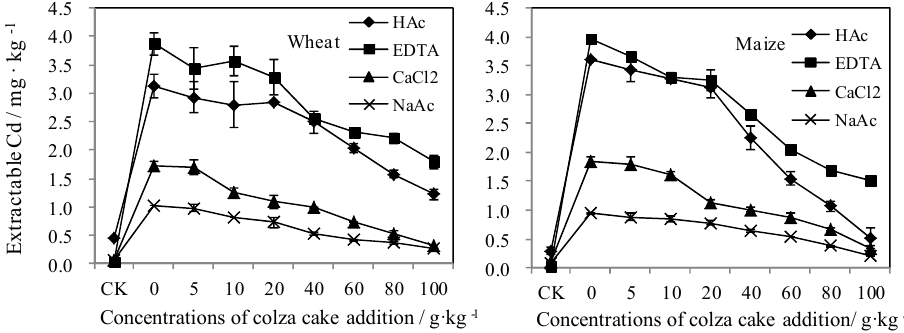
Figure 7. The bioavailable concentrations of Cd measured by different extraction methods after the addition of colza cake in Cd-contaminated soils grown by wheat and maize, respectively.